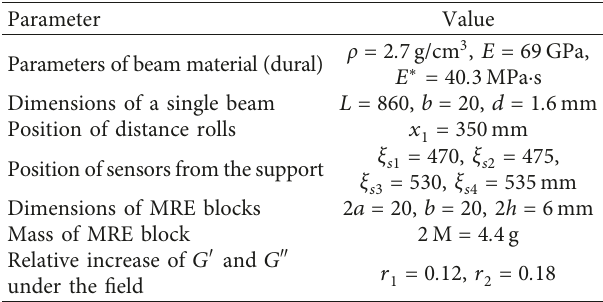
Figure 18: The test stand for the investigation of the control applied to the MRE element. Table 4: Fundamental parameters of the second test